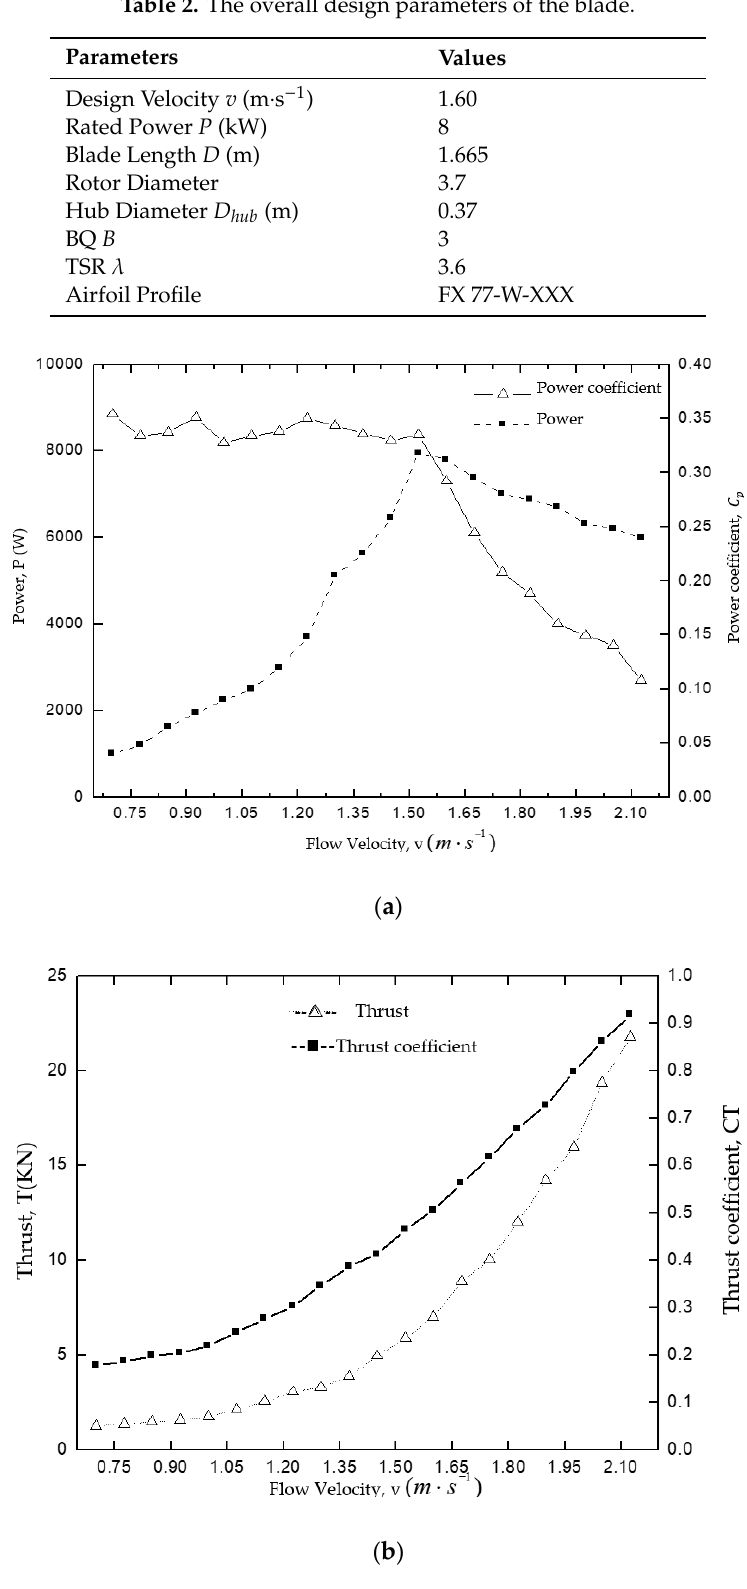
Figure 7. Performance prediction of the blade under di ff erent velocities; ( a ) power curve and power coe ffi cient curve at di ff erent velocities, and ( b ) thrust curve and thrust coe ffi cient at di ff erent